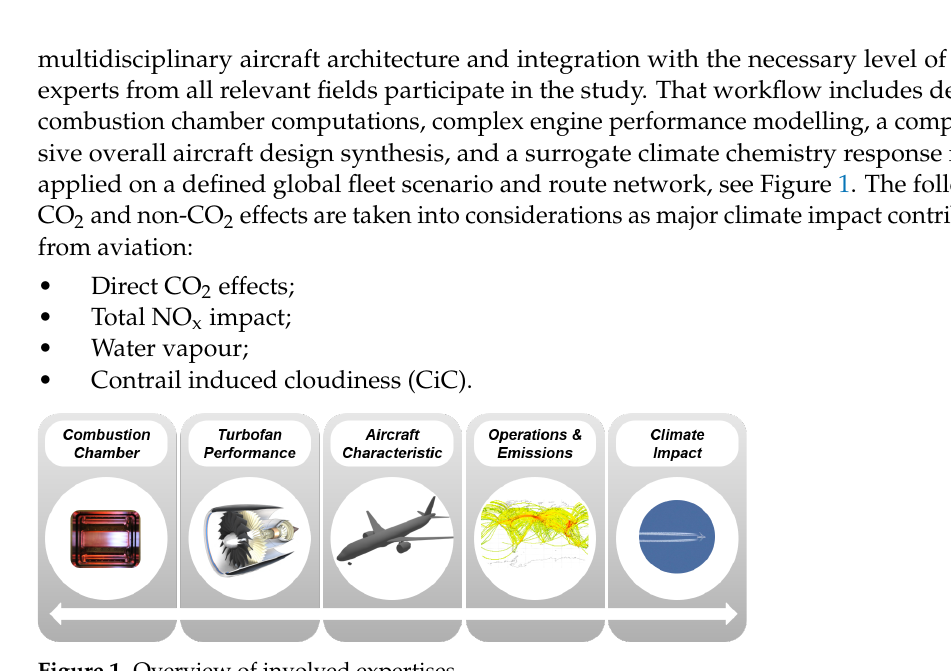
Figure 1. Overview of involved